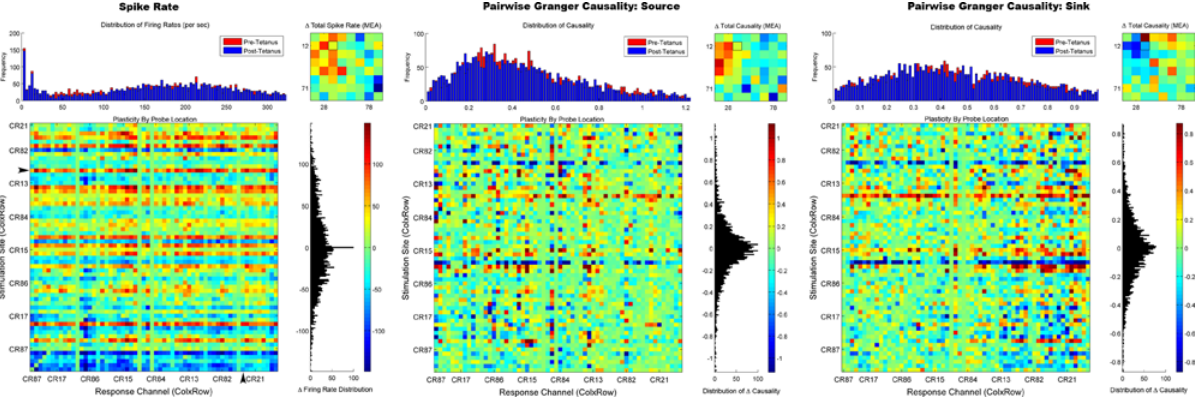
Figure 9. Comparison of Firing Rate and Pairwise Granger Causality Plasticity Measures. The neural activity of rat cortical neurons were stimulated to induce plasticity and recorded using an 8 6 8 grid of MEA electrodes (shown earlier in Figure 1). The left, middle, and right panel represent plasticity suggested by changes (enhancement or depression) in firing rate, pairwise Granger causality for outgoing ‘‘source’’ and incoming ‘‘sink’’ relationships, respectively. Each panel presents in clockwise order the distribution of values, average total changes by spatial location, distribution of the direction of change, and changes by probe location for each of the three measures. The vertical axis represents the stimulation probe site among the 60 electrodes on the MEA. The horizontal axis represents the network’s response at each electrode to each probe. Each pixel is color coded to indicate the magnitude and direction of any changes that occurred following the tetanus. Application of the tetanus resulted in substantial changes in the strength of connections among neurons in this network. Comparison of those changes using a firing rate based verses a Granger causality based measure indicates a great deal of similarity between each measure. Rows where spike rate was enhanced in left panel also tended show a stronger causal relationship in the right panel. Similarly, rows indicating depression were associated with depressed causal strength in the right panel. A black arrow along the vertical and horizontal axis denote the electrode that received the tetanizing stimulus to induce plasticity. The color scale has been set to + / 2 3 standard deviations for each